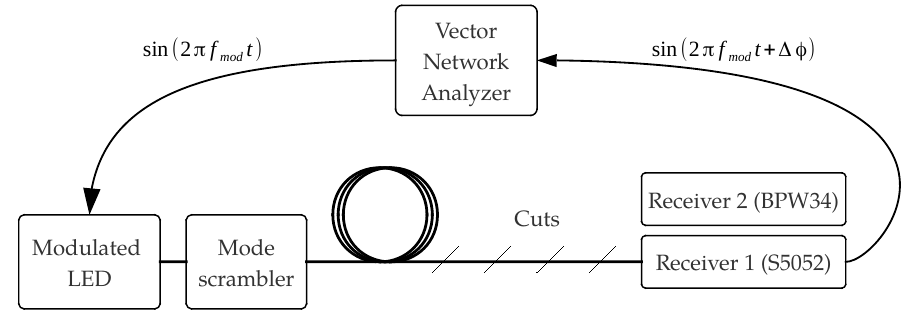
Figure 11. Measurement